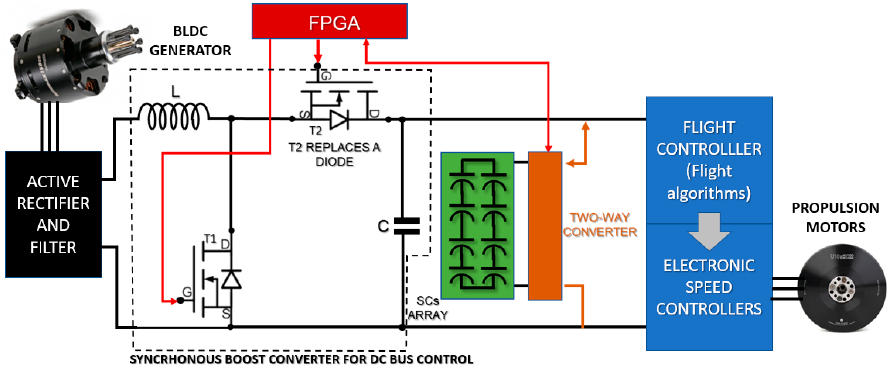
Figure 6. Simplified architecture of the hybrid generator.